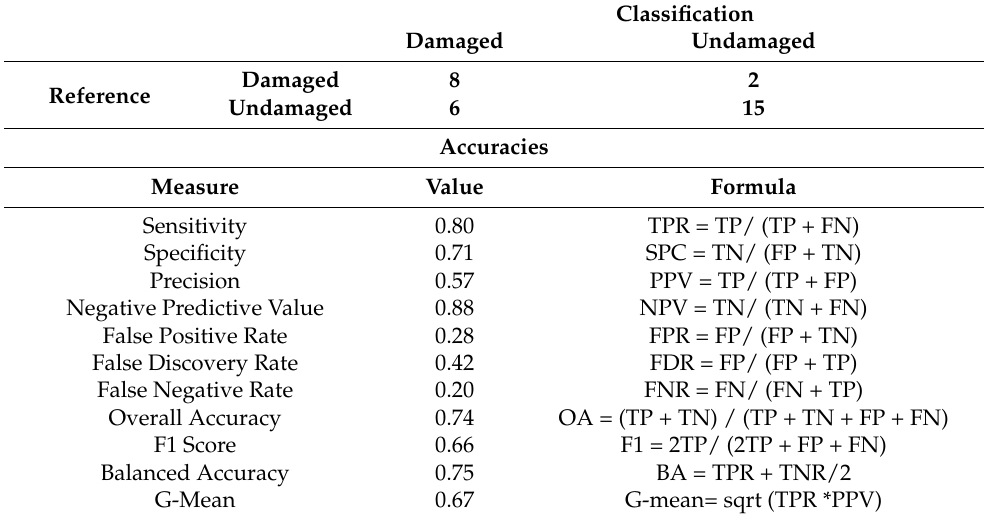
Table 2. Metrics derived from the confusion matrix of the DM with respect to the test set. True positives (TPs): number of damaged elements predicted as damaged; false positives (FPs): number of undamaged elements predicted as damaged; false negatives (FNs): number of damaged ele- ments predicted as undamaged; true negatives (TNs): number of undamaged elements predicted as undamaged. Classification Damaged